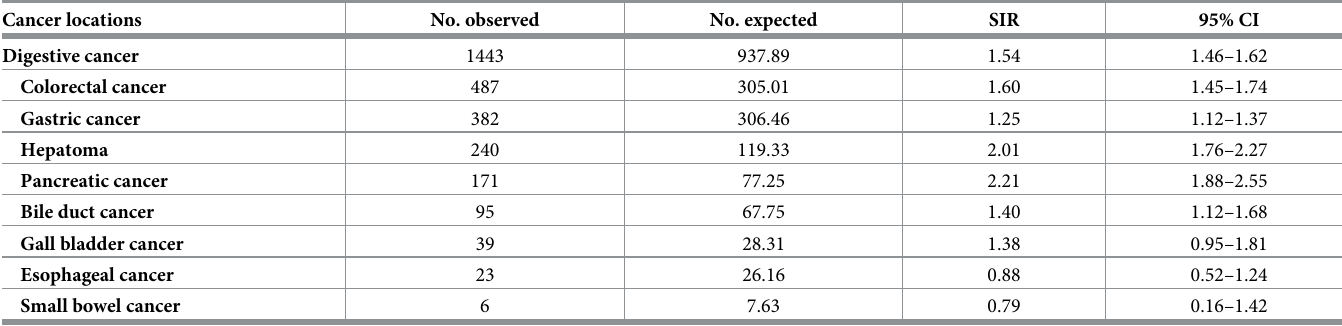
Table 2. Standardized incidence ratio of digestive cancer in pre-dialytic CKD patients compared with cohort